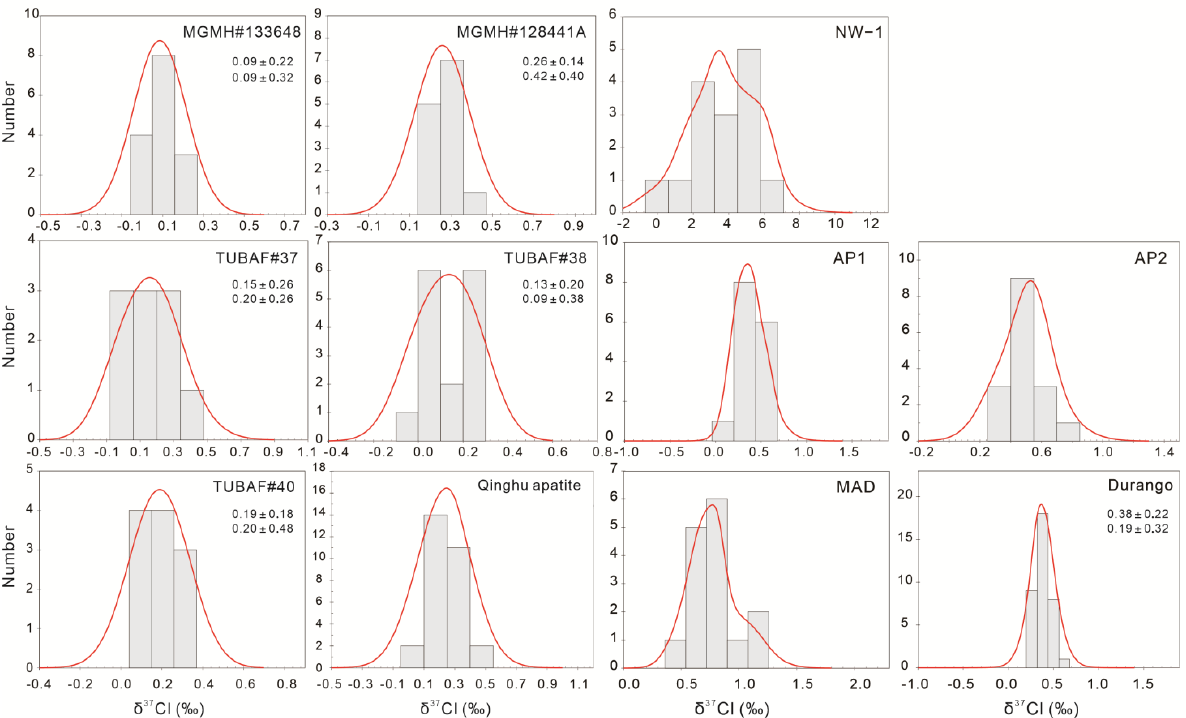
Figure 4. Probabilistic histograms of the δ 37 Cl of the 11 samples used in this study, calibrated against Durango.